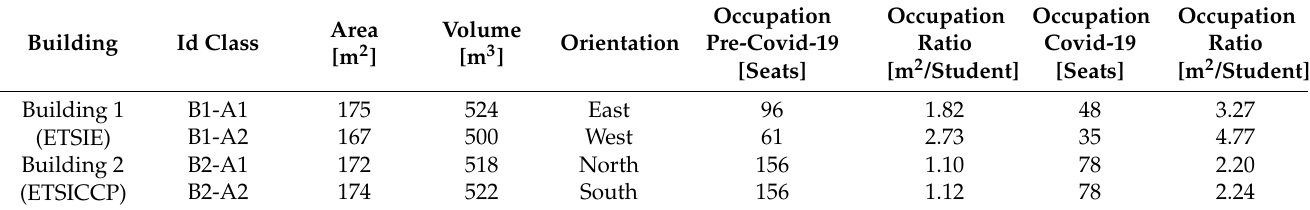
Table 1. Characteristics of the